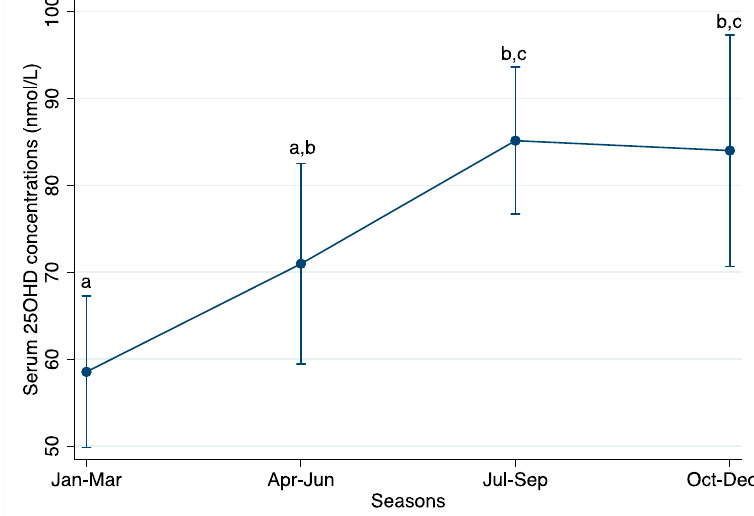
Figure 1. Marginal mean (95% CI) serum 25OHD concentrations by season based on n = 145 serum 25OHD measurements collected in the past 5-year period (2012–2017). Number of samples measured in each season were: n = 47 in Jan–Mar; n = 28 in Apr–Jun; n = 50 in Jul–Sep; and n = 20 in Oct–Dec. Values are marginal means (95% CI). An analysis of variance (ANOVA) model was used to predict the marginal means (95% CI) of 25OHD concentrations by season, controlling for age and repeated-measures of individuals. Values that do not share a common superscript letter in the column are significantly different from each other (Bonferroni-adjusted for multiple comparisons, P < 0.0125 to account for the four-group comparison).